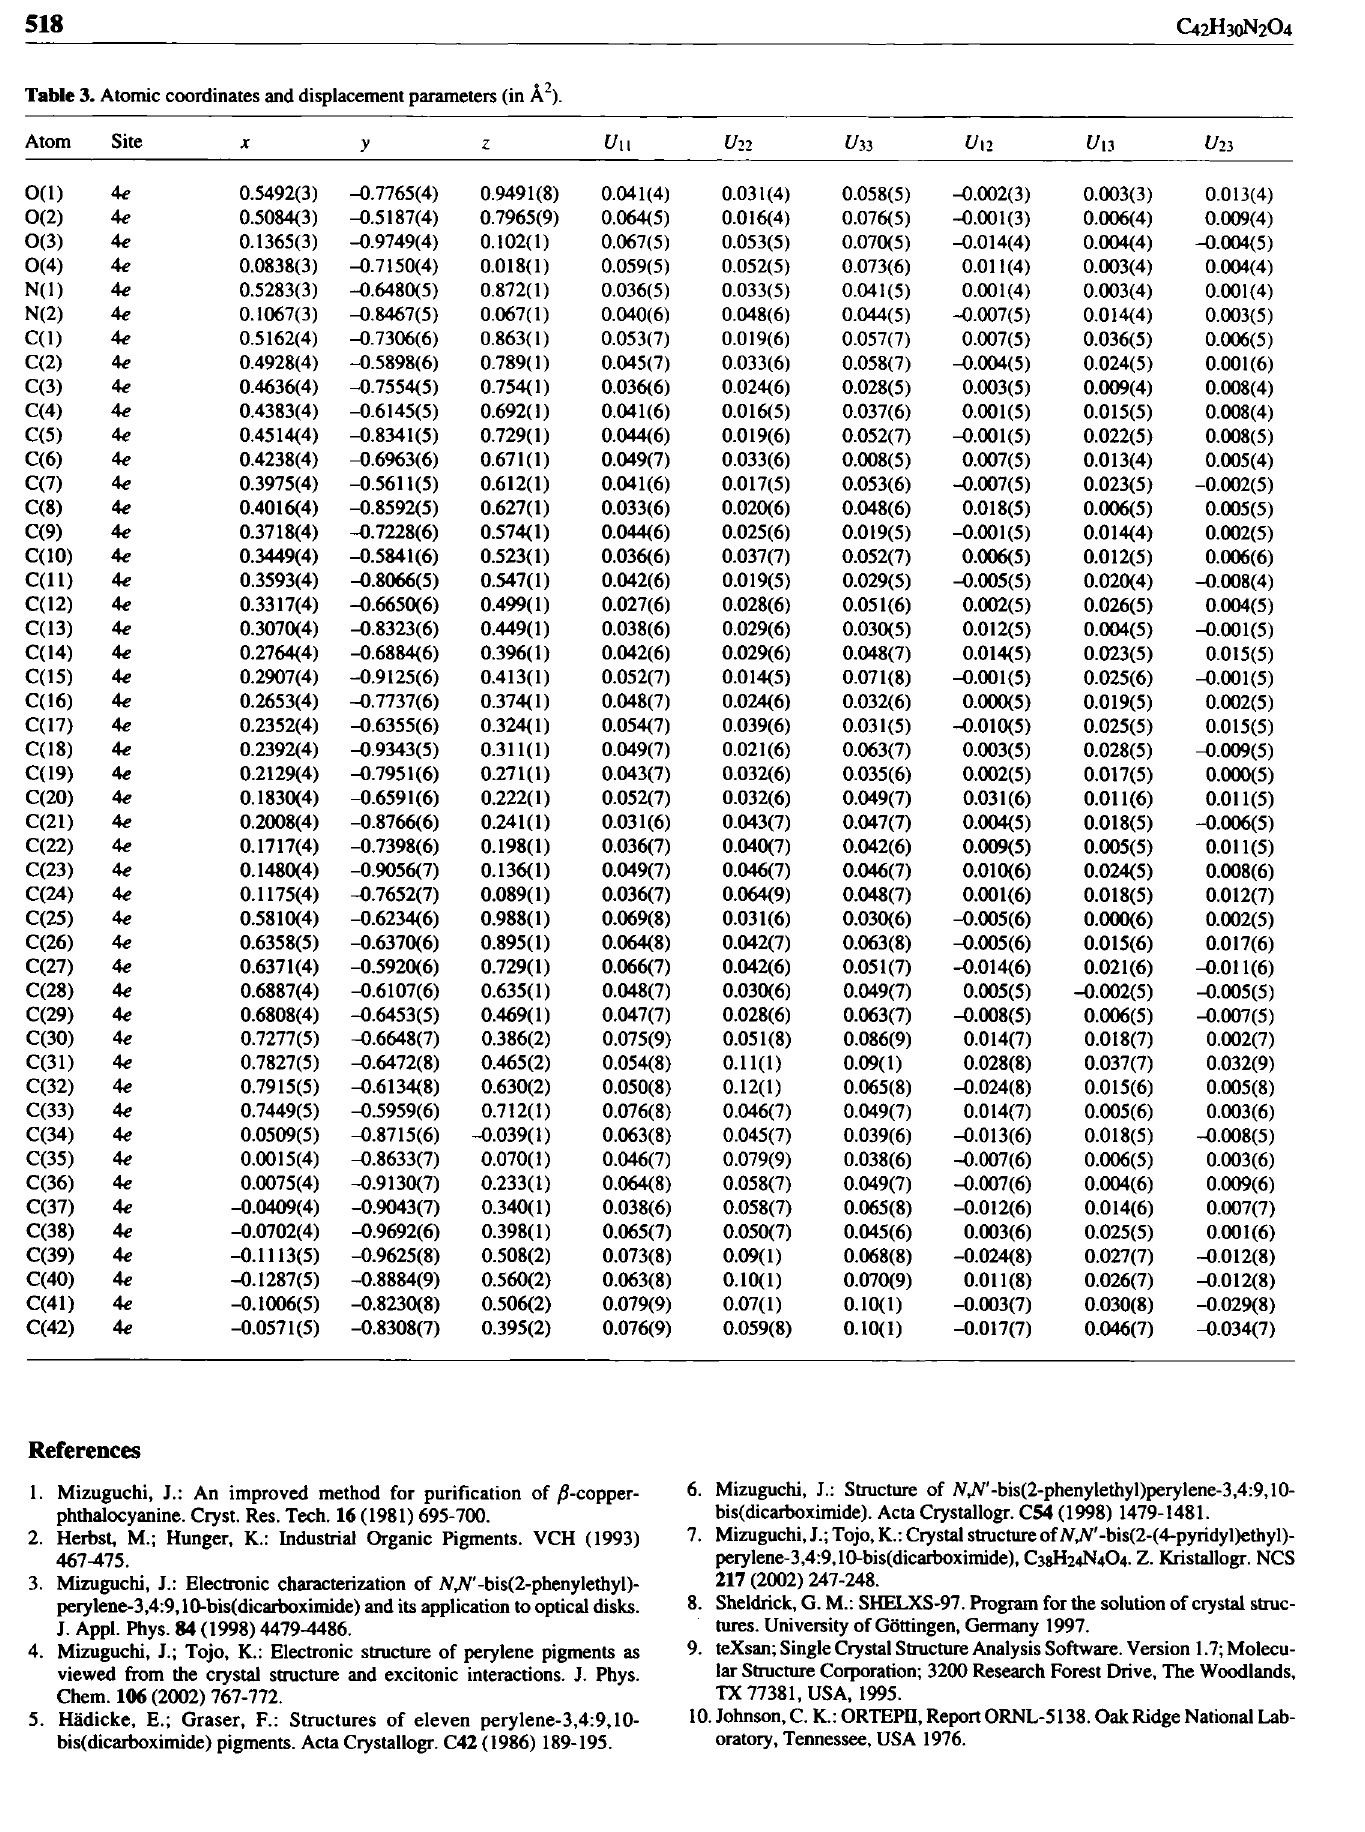
Table 3. Atomic coordinates and displacement parameters (in Â 2